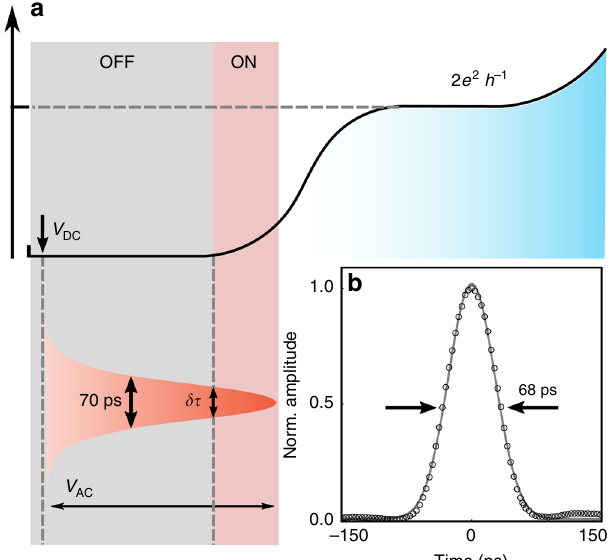
Fig. 5 A QPC as a fast switch. a Operation diagram of our fast QPC switch.